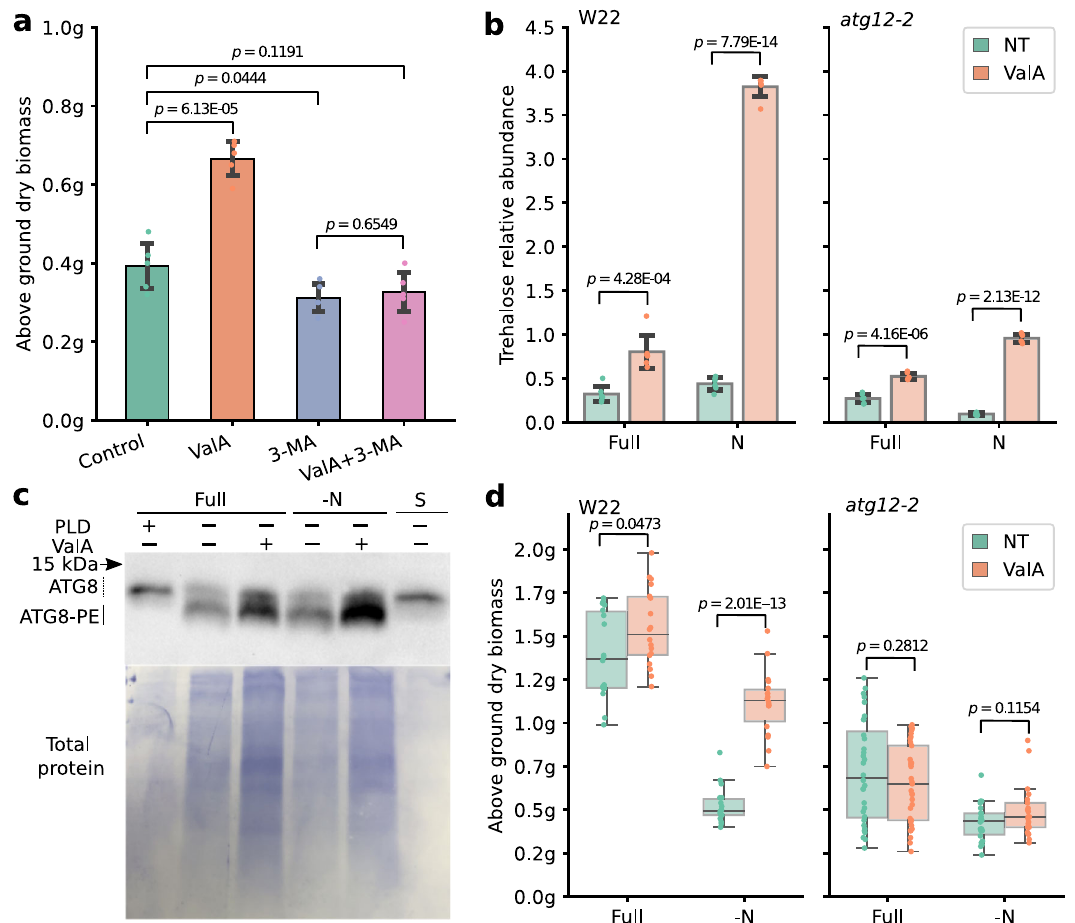
Fig.6|ValidamycinAinducedbiomassproductivityisdependentontrehalose- mediated autophagy. a Accumulation of above ground dry biomass for 3-week- oldcontrolseedlings(green),seedlingstreatedwith3mM3-MA(3-methyladenine) (orange),30 µ M ValA(purple)orboth3mM 3-MAand 30 µ M ValA(pink)measured in grams (g). ( N =5 individual plants). b Accumulation of trehalose in W22 and homozygous atg12-2 mutant seedlings across treatments and conditions ( N =6 individual plants). Error bars in panels a and b indicate standard deviation. For panels a , b , statistical signi fi cance between indicated comparisons were deter- mined by two tailed t -test. c Change in the abundance of free ATG8 (upper band) and ATG8-PE conjugate (lower band) in the roots of three week old maize plants